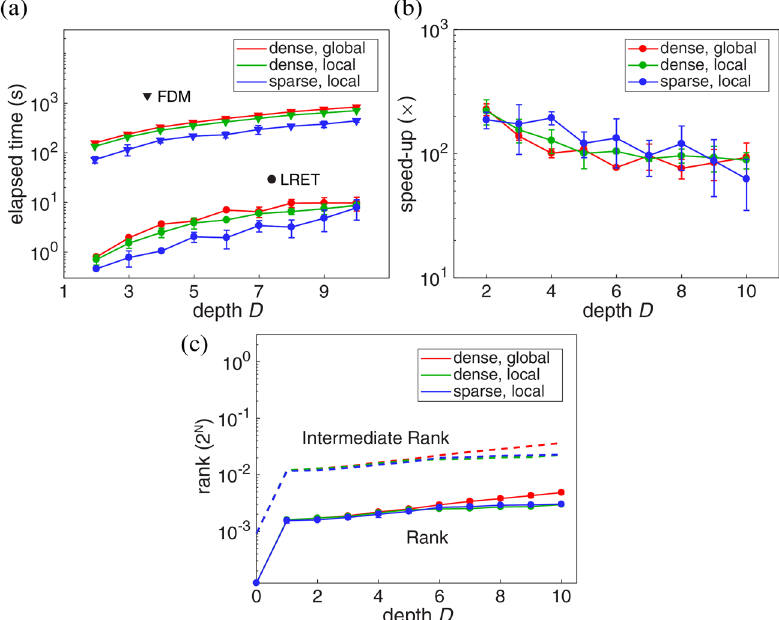
Fig. 8 Benchmarking for different circuit types under bit fl ip noise. a Averaged elapsed time for quantum circuits with different gate sparsity and connectivity. For the sparse circuit, the sparsity is 50%. b Speedup of LRET for different circuit types. c The evolution of rank (circle) and intermediate rank (dashed line) of density matrix for different circuit types. The distortion values for each of the circuits simulated using the LRET method are similar and are all <9.2%. The parameters are p = 0.1%, N = 13, and ϵ = 10 − 4 . The error bars are standard-deviation- calculated across a set of